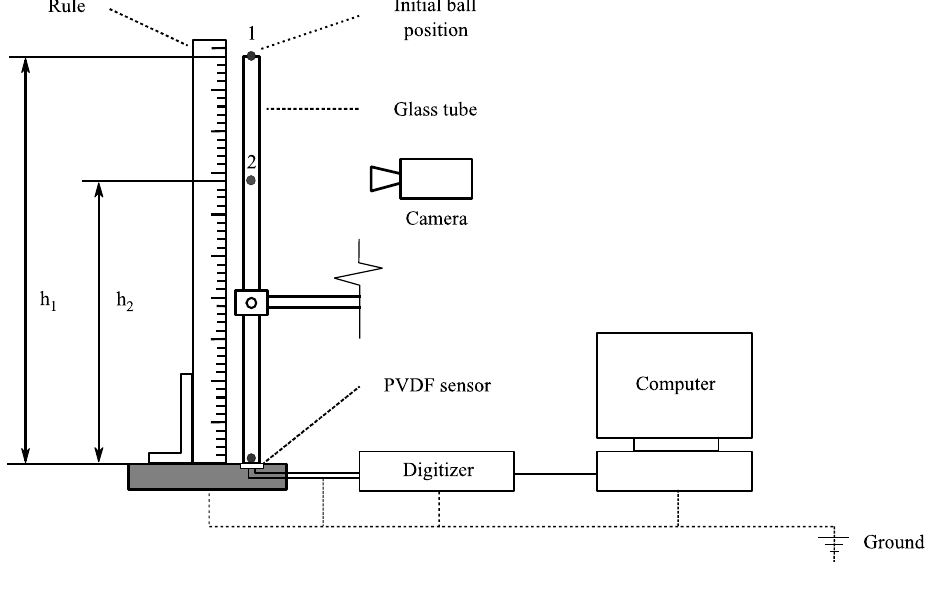
Figure 6. The ball drop testing method experimental setup.